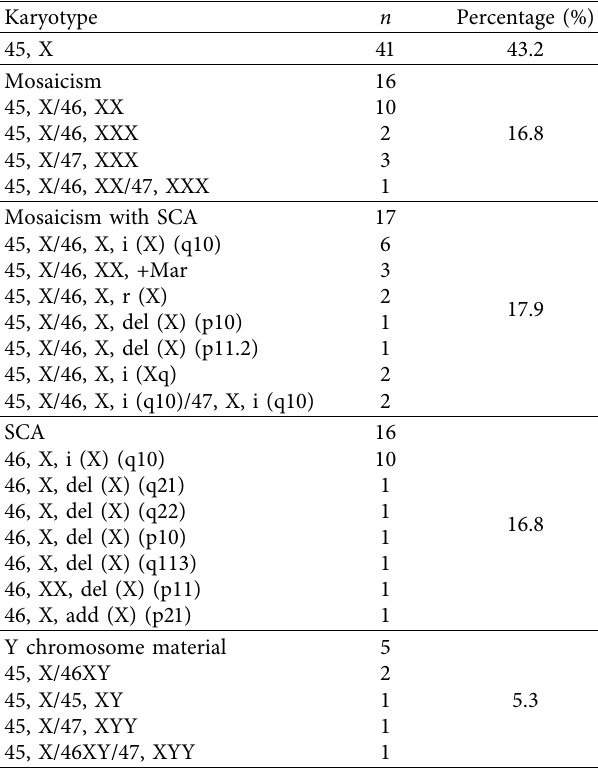
SCA: structural X chromosome abnormalities; Mosaicism with SCA: mosaicism with structural X chromosome